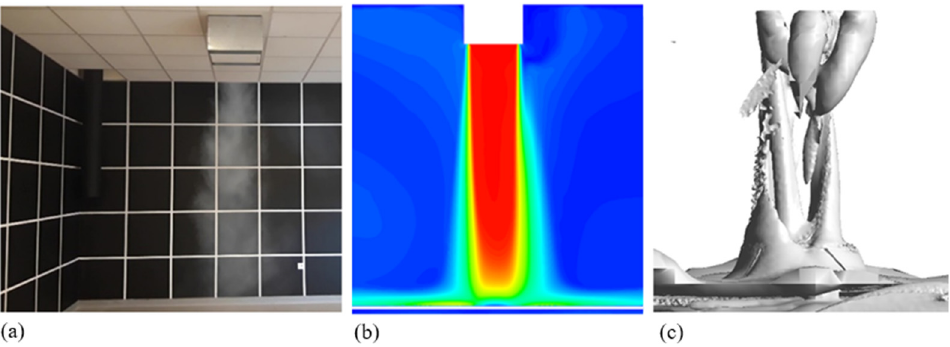
Figure 8. Experimental ( a ), modelled velocity ( b ) and Q-criterion ( c ) diffuser inflow.